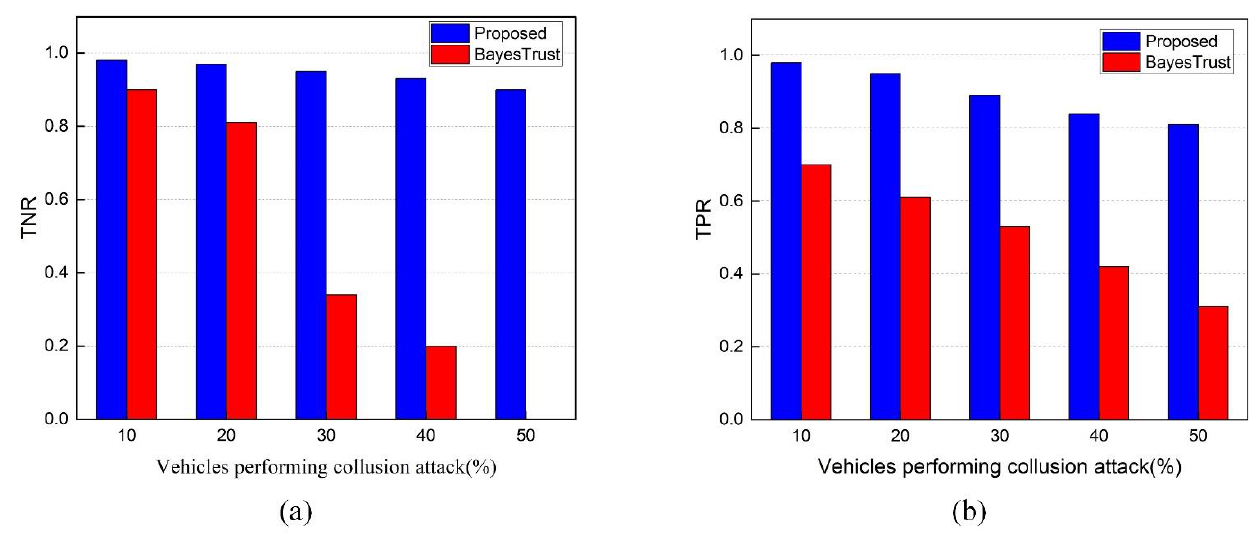
Figure 9. Experiments ( a , b ) represent TNR and TPR under collusion attack.